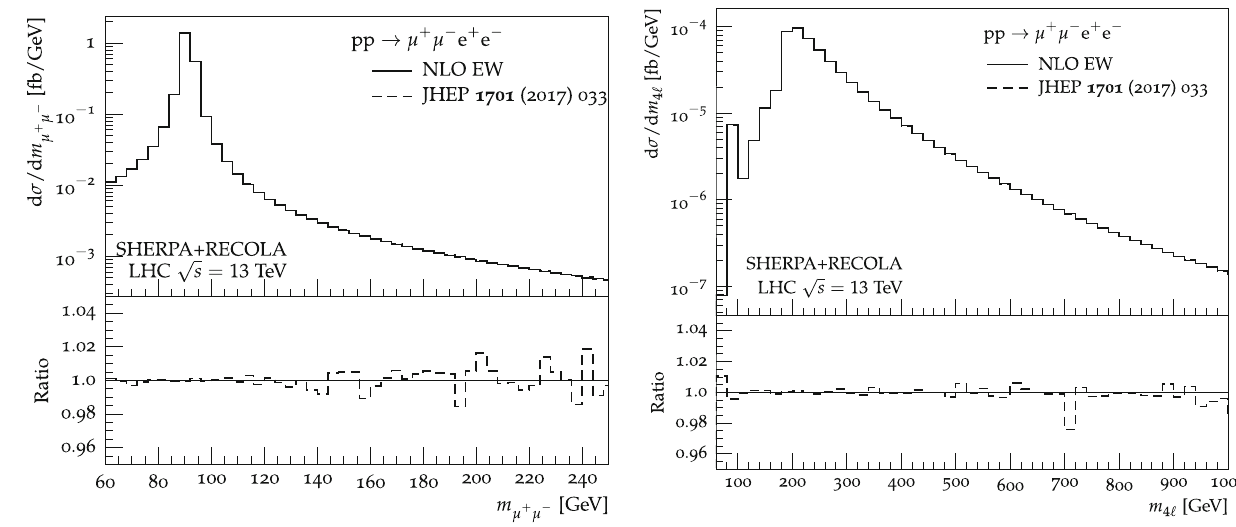
Fig. 13 Comparison of the di-muon and four-lepton invariant mass in the process pp → μ + μ − e + e − at NLO EW with the Sherpa + Recola interface compared against the benchmark numbers from Ref.